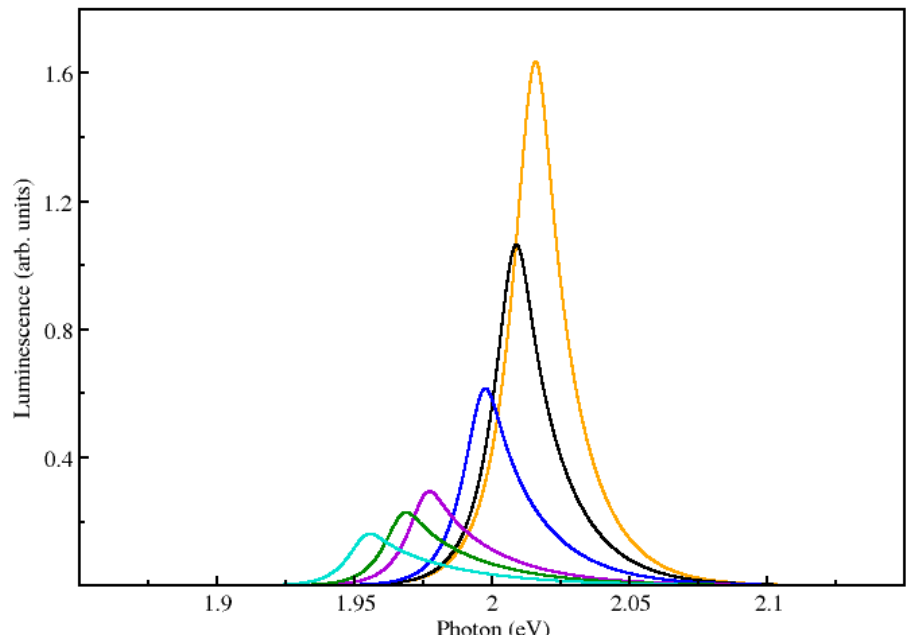
Figure 5. Luminescence for a GaAs–Al 0.3 Ga 0.7 As superlattice with repeated barrier and well widths equal to 2 nm. All curves have been calculated with the same broadening Γ = 5.4 meV and a carrier density N = 10 14 cm − 3 From left to right, the orange, black, blue, violet, green and turquoise curves have been calculated for temperatures given respectively by T = 150 K, 170 K, 200 K, 250 K, 270 K, and 300 K. The corresponding free carrier bandgaps needed for input are E 0 g = 2.021 eV, 2.015 eV, 2.003 eV, 1.982 eV, 1.974 eV, and 1.960 eV.